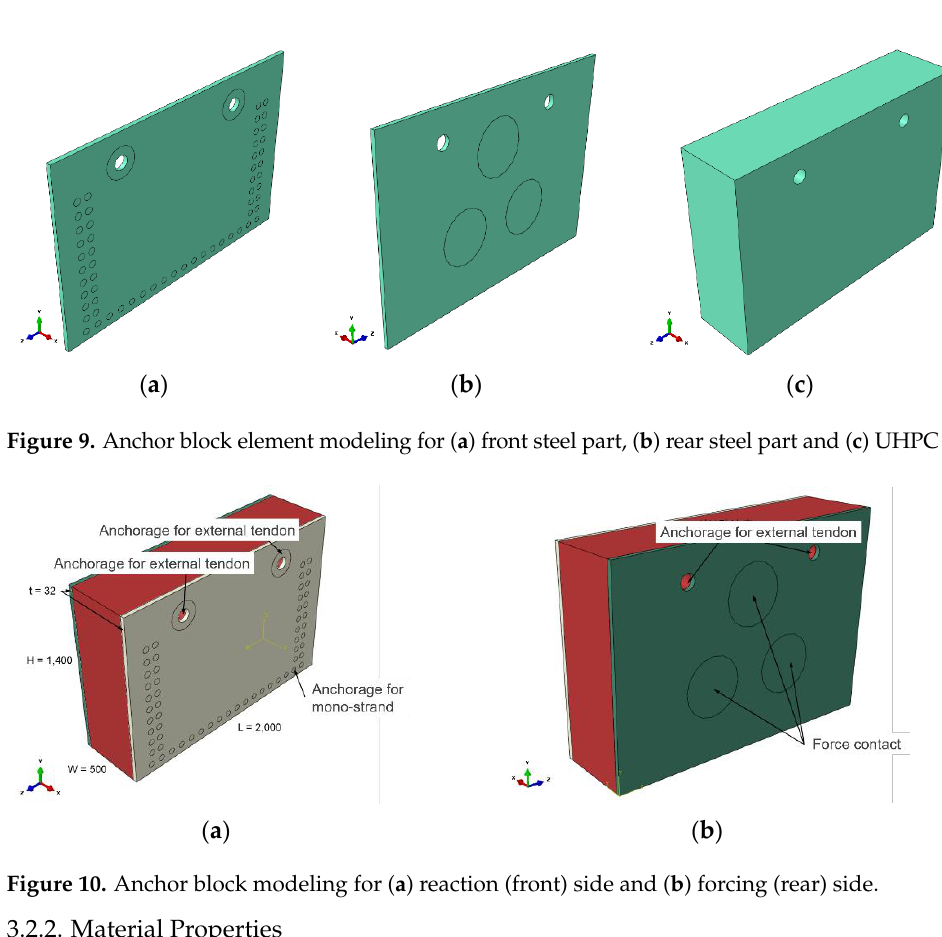
Figure 10. Anchor block modeling for ( a ) reaction (front) side and ( b ) forcing (rear) side.